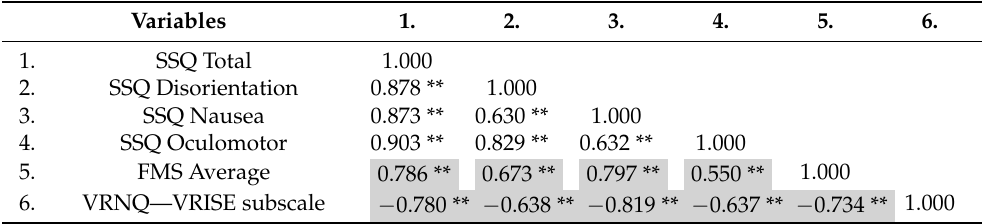
Table 4. Correlation matrix for LA_NORF condition—Spearman ( ρ ) correlation coefficients for combined VRISE measures ( n = 6).